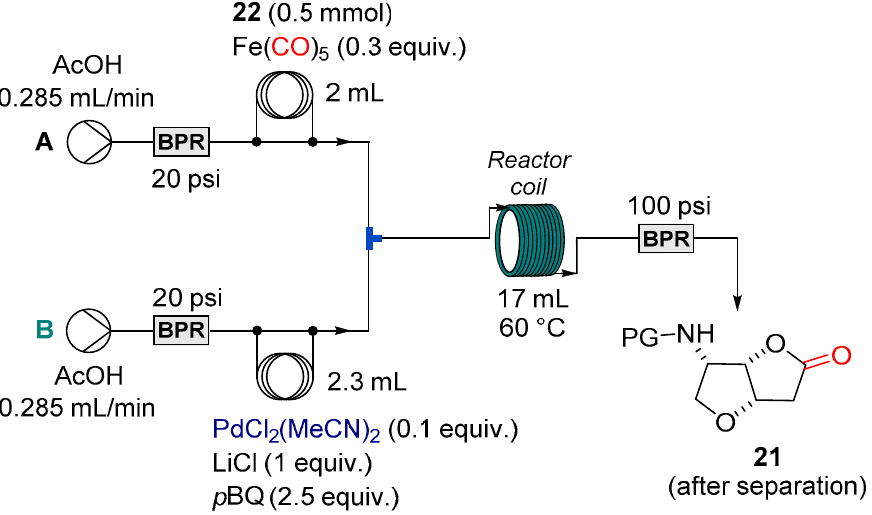
Figure 4. Comparison of known and new conditions for Pd-catalysed carbonylative cyclisation. The new reaction conditions were then tested in the preparation of key intermediate- lactone 21 for the synthesis of jaspine B 1 in continuous flow mode (Scheme 9). The flow setup consisted of two reaction streams which were pumped using HPLC Azura pumps via injection coils to a preheated reactor coil. The composition of stock solutions were adjusted to avoid the decomposition of Fe(CO) 5 in the presence of oxidation reagents ( p BQ). The following continuous reaction of 22 on 0.5 mmol scale provided the desired N -protected bicyclic lactones 21 in comparable yields to standard batch and flow conditions (Table 3).